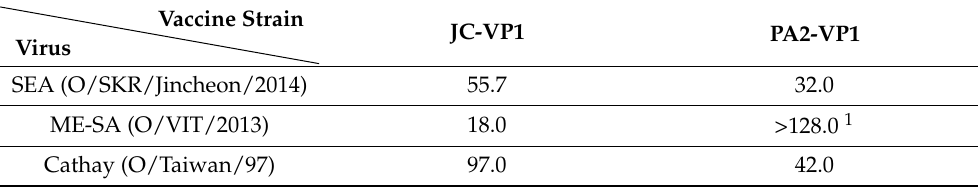
Table 1. Protection test (PD 50 ) performed in vaccinated mice using 3 topotype challenge viruses.